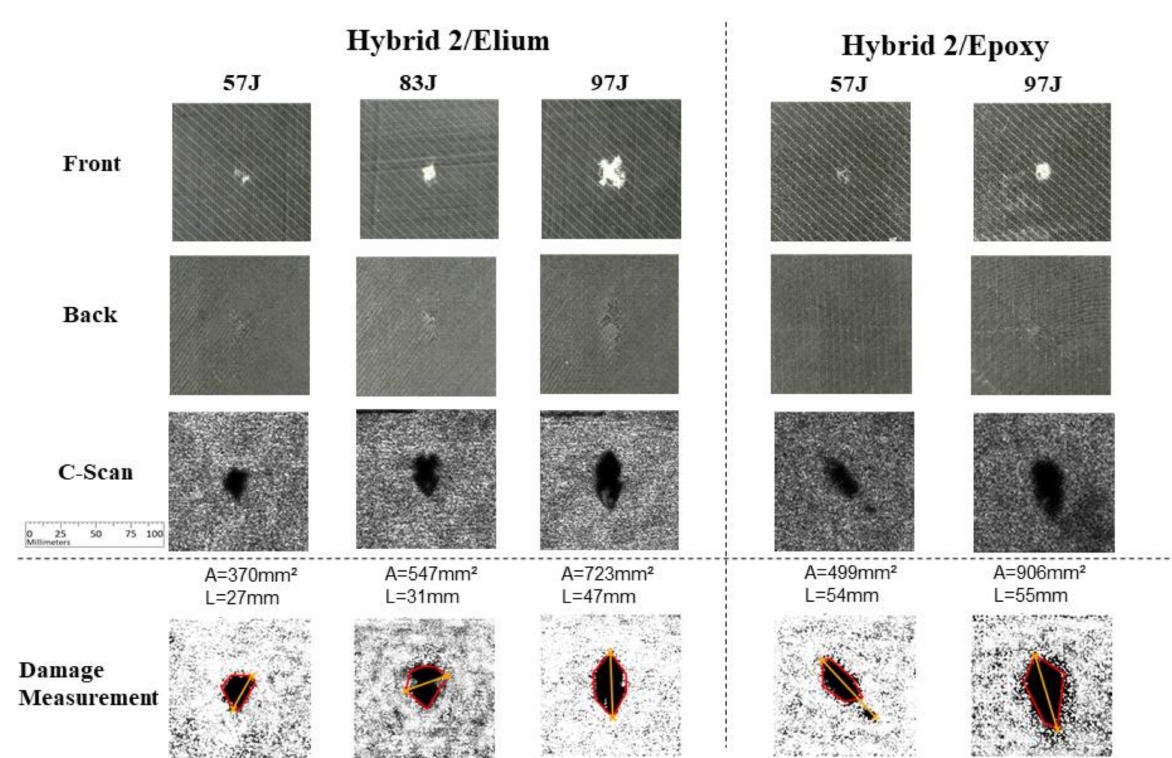
Figure 16. Experimental results for Hybrid 2 carbon/glass fibers specimens. As observed in the literature [6,7,32,33,37,83] regarding failure modes, Elium-based specimens, if compared to Epoxy-based counterparts, presents a less brittle failure